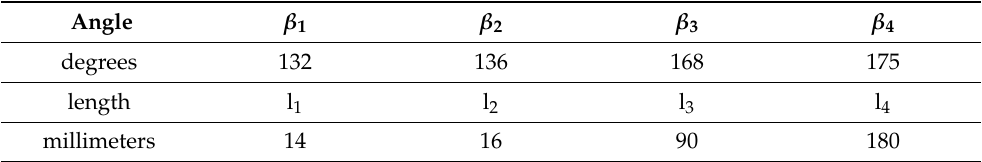
Table 1. Final dimensions of the limb shape profiles.